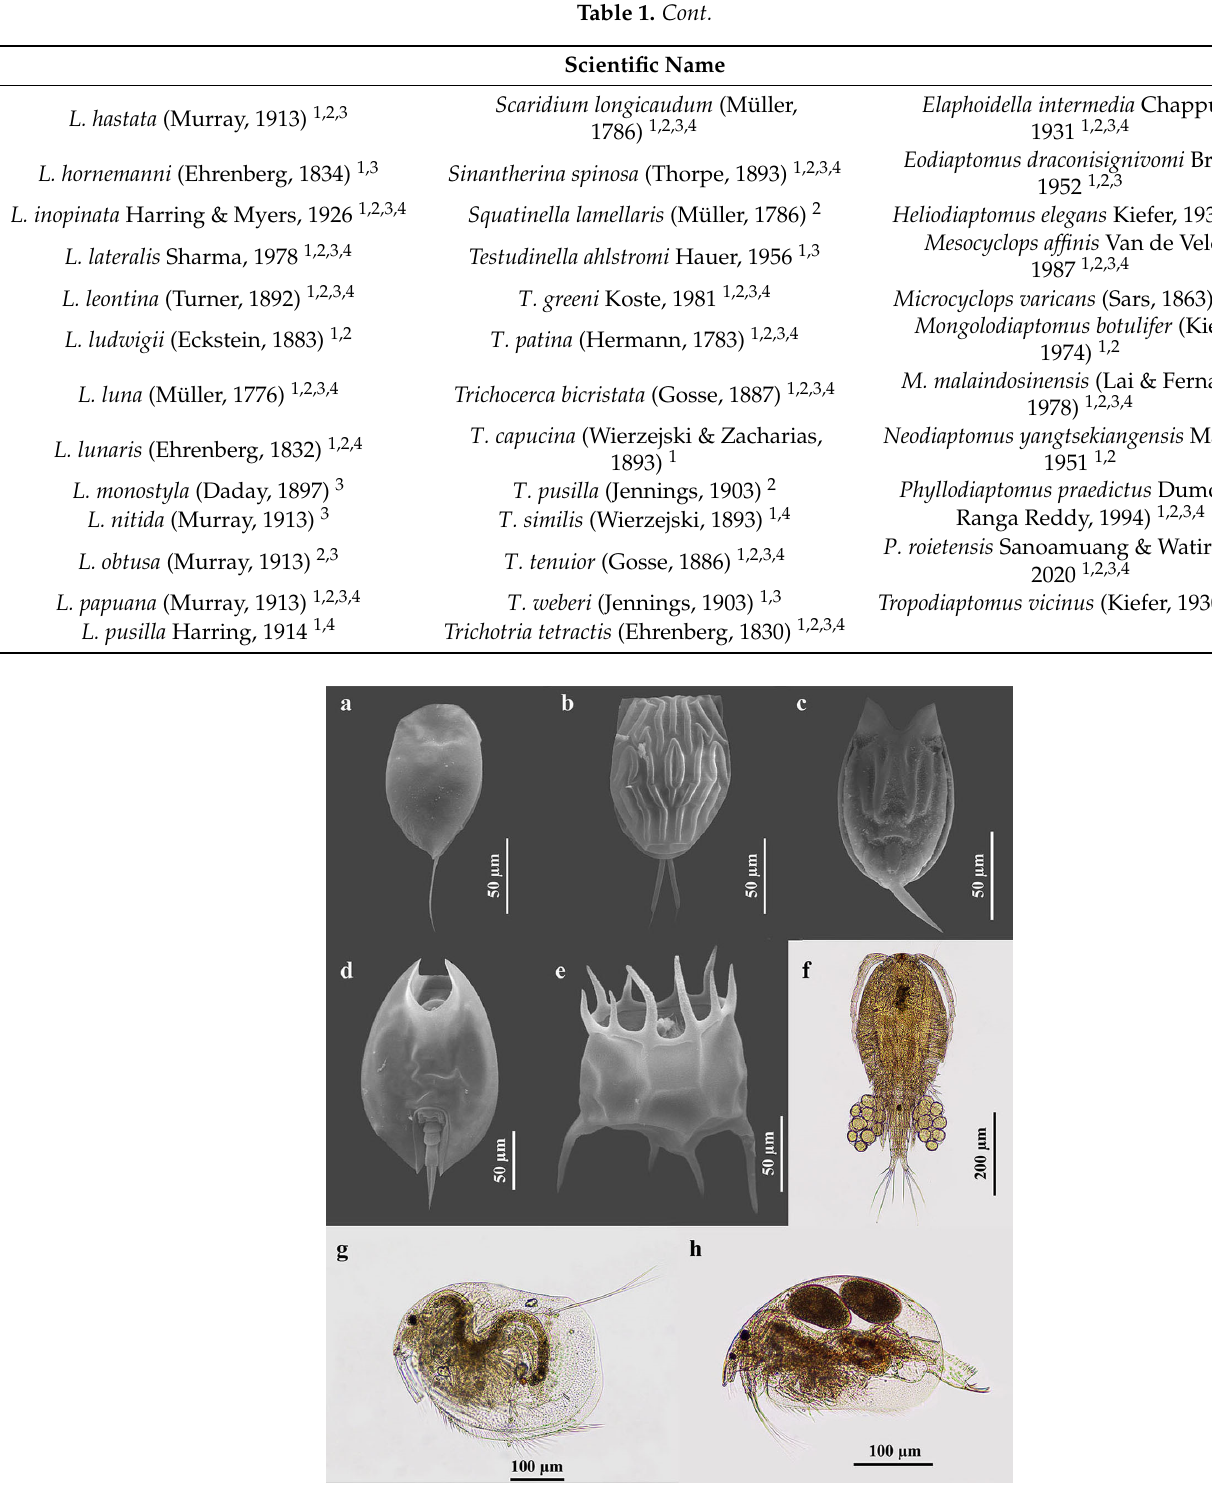
Figure 3. Some zooplankton species that were found in the present study. ( a ) Colurella sanoamuangae Chittapun, Pholpunthin & Segers, 1999; ( b ) Lecane baimaii Sanoamuang & Savatenalinton, 1999; ( c ) Lecane hamata (Stokes, 1896); ( d ) Lepadella ovalis (Müller, 1786); ( e ) Plationus patulus (Müller, 1786); ( f ) Mesocyclops affinis Van de Velde, 1987; ( g ) Grimaldina brazzai Richard, 1892; and ( h ) Ovalona cambouei (Guerne & Richard, 1983).